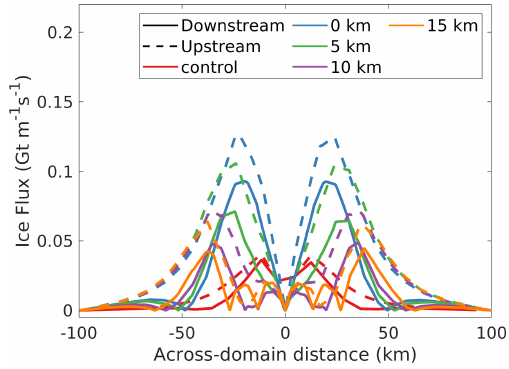
Figure 8. Ice flux (in Gtm − 1 s − 1 ) across transects 20km upstream (dashed lines) and 20km downstream (solid lines) of the nunatak summits ( x = 50km), as illustrated in Fig. 7a. Line colours denote the varying widths of glaciers separating the three nunataks, while “control” (red line) refers to the one-nunatak experiment. Note how the experiment where glaciers are 15km wide yields a profile clos- est to that of the control